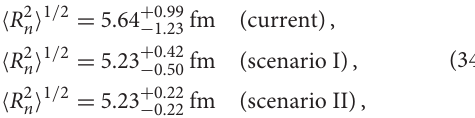
panel of Figure 7 . The obtained constraint at 90% C.L. reads